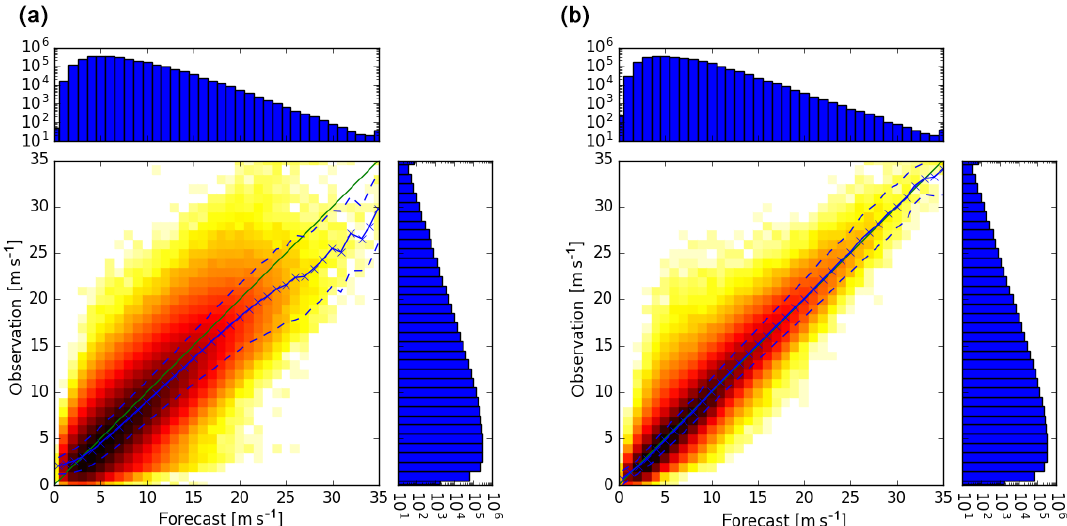
Figure 6. Scatter plots of ensemble means of 3h forecasts of the speeds of wind gusts of COSMO-DE-EPS versus observations (a) and cor- responding statistical fits of 1h forecasts of Ensemble-MOS versus the same observations (b) . Means of observations (solid) and confidence intervals (means ± standard deviations, dashed) are shown. Six years of data (2011–2016) are used; number of cases are given by histograms.